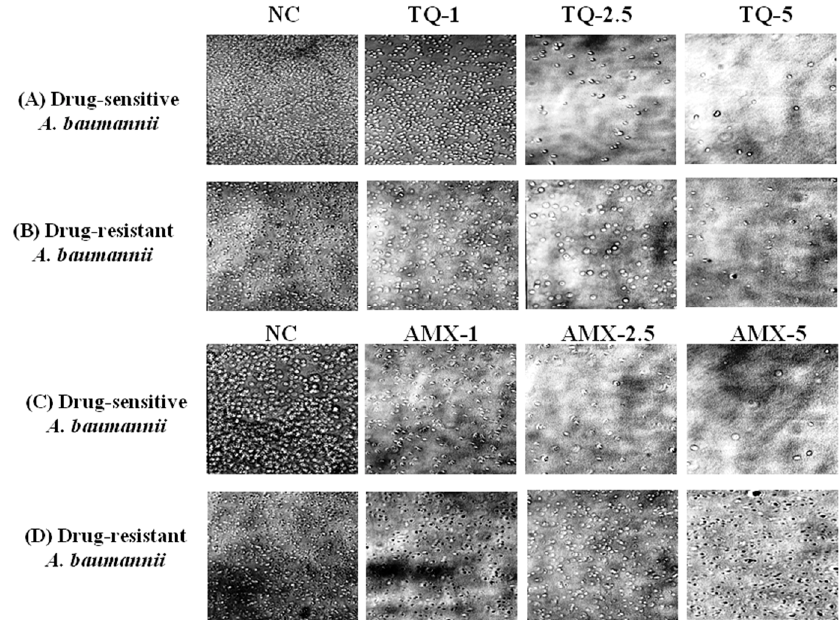
Figure 4. Microscopic analysis of the effect of TQ or AMX against the drug-sensitive and drug-resistant A. baumannii . The activity of TQ (1, 2.5 and 5 μ g/mL) against the ( A ) drug-sensitive and ( B ) drug-resistant A. baumannii . The activity of AMX (1, 2.5 and 5 μ g/mL) against the ( C ) drug-sensitive and ( D ) drug-resistant A. baumannii . Negative controls (NC) contain 5% DMSO.